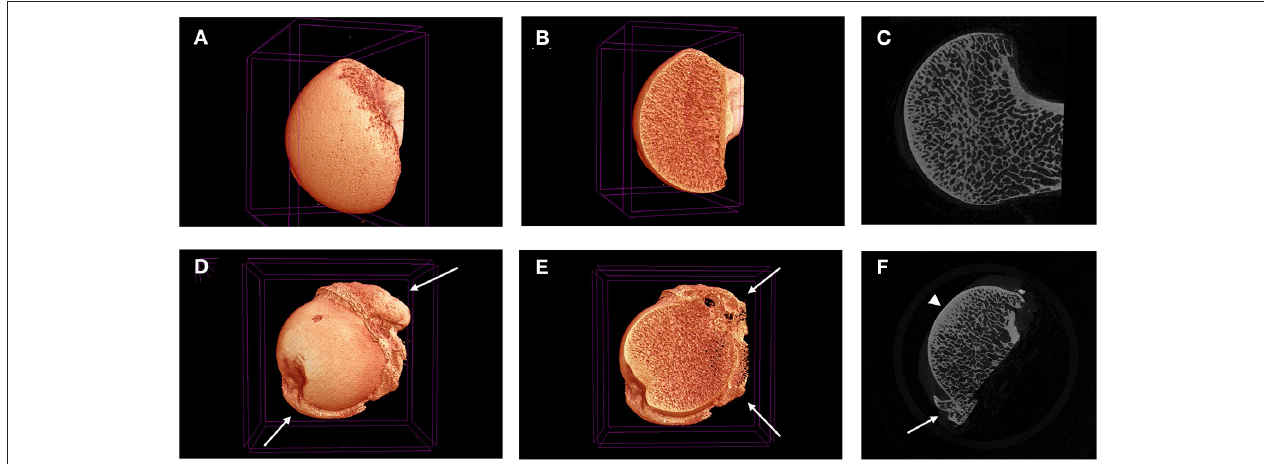
FIGURE 6 | Micro-CT 3D reconstructions (A,B,D,E) and tonograms (C,F) of two canine femoral heads. Images (A–C) are taken from normal femoral head, while images (D–F) are taken from a diseased femoral head harvested during a total joint replacement. Peripheral osteophytes are visible in D-F (white arrows), as well as thickening in the subchondral bone plate (arrow head).